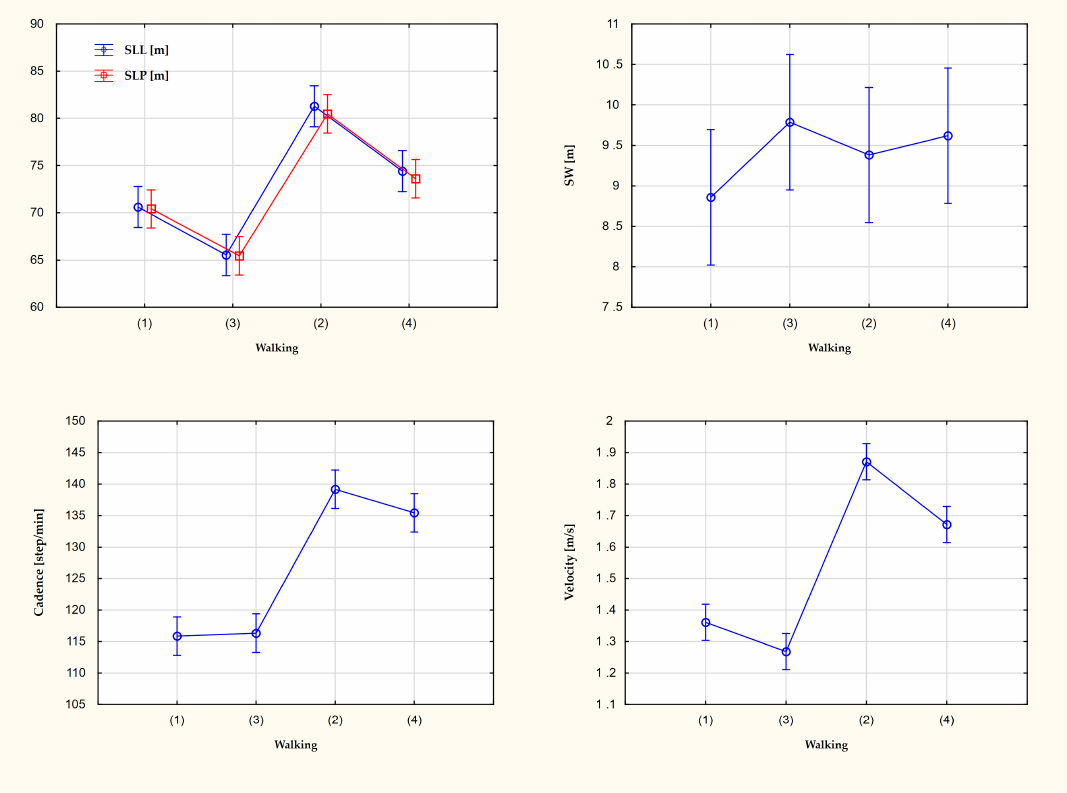
Figure 1. Changes in gait parameters depending on the walking velocity and the use or not of the phone. Trial (1)—walking without a phone with comfortable velocity. Trial (2)—walking without a phone with fast velocity. Trial (3)—walking with the phone with comfortable velocity. Trial (4)— walking with the phone with fast velocity. SLL [cm]—step length left, SLR [cm]—step length right, SW [cm]—step width.